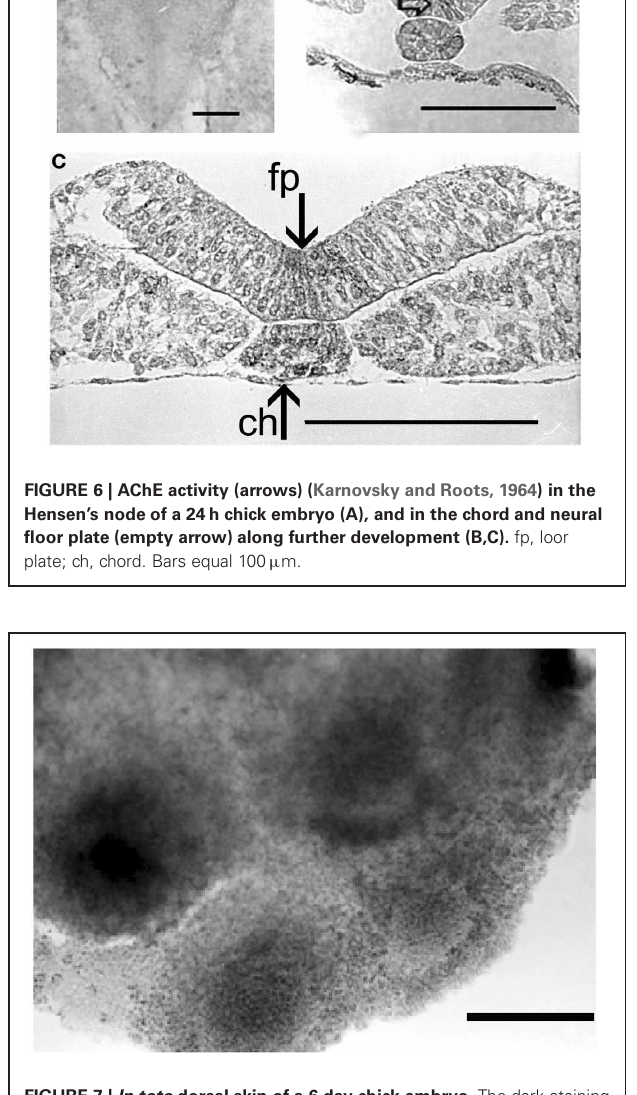
FIGURE 7 | In toto dorsal skin of a 6 day chick embryo. The dark staining reveals AChE activity by the Karnovsky and Roots (1964) method. Bar equals 100 μ m.